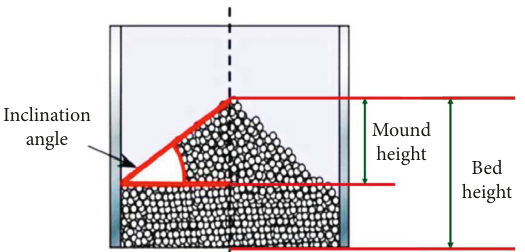
Figure 10: Schematic illustration for inclination angle, mound height and bed height.